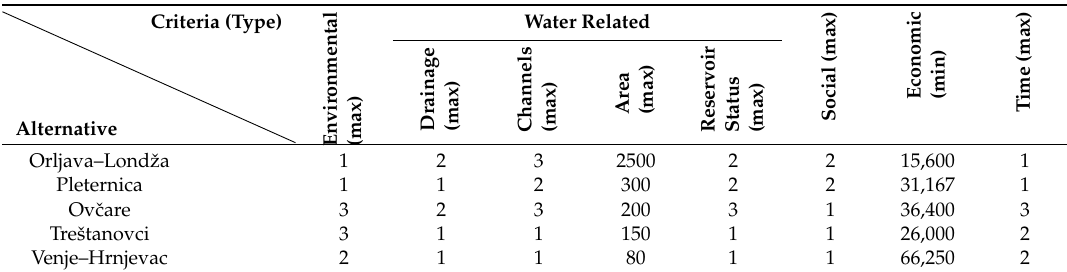
Table 4. Quantitative assessment of alternatives by criteria.